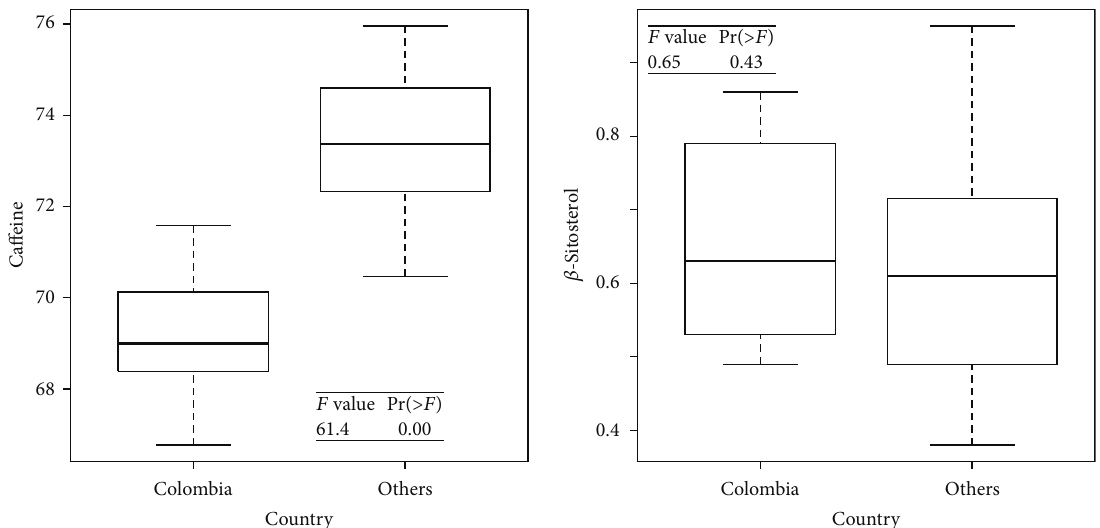
Figure 1: Box-plots for caffeine 𝛿 13 C ratios obtained by GC-C-IRMS and for the 7 compounds quantified by GC-MS. The 𝐹 values and corresponding 𝑝 values were computed by ANOVA for each predictor. Although several predictors were found to be significantly different for both groups, the overlap observed between the distributions already suggested that the accuracy of the classifier would depend on the number of predictors included in the